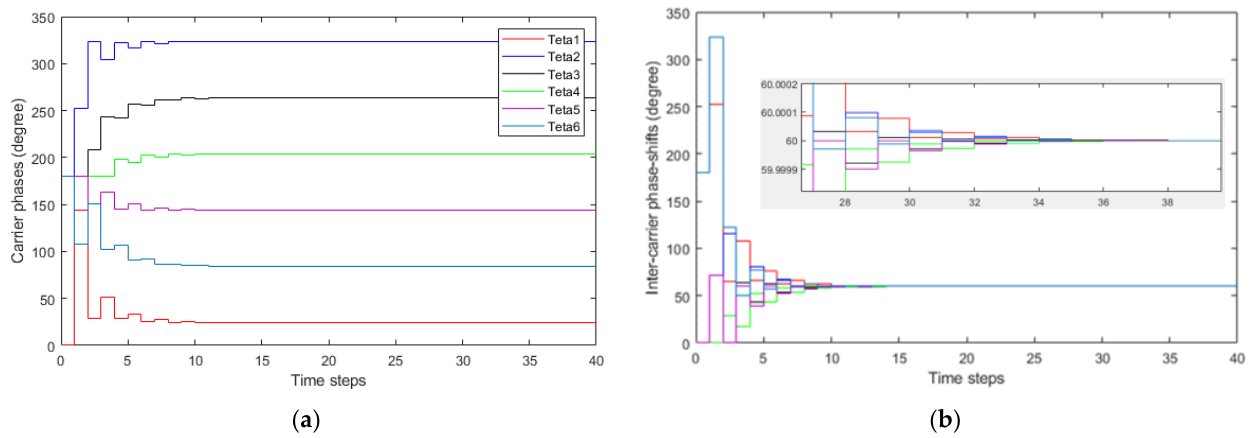
Figure 3. Analysis of convergence for a six-carriers system, ( a ) carrier phase; ( b ) inter-carrier phase-shift.